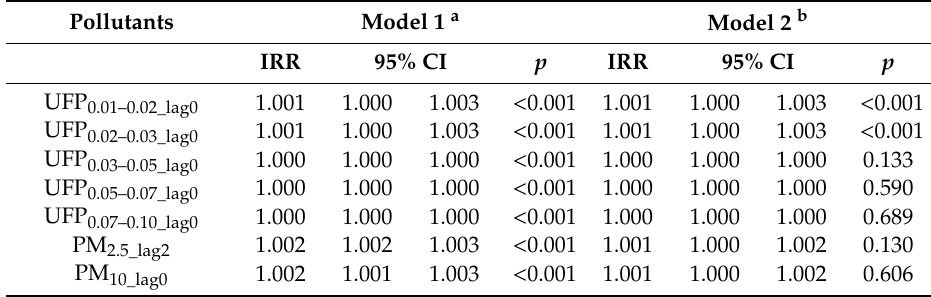
Table 2. Association between the daily number of consultations due to diabetes mellitus by all age groups and the average 24-h number concentration of UFP (number / cm 3 ); average 24-h concentration of PM 10 and PM 2.5 ( µ g / m 3 ) in the MOL, Slovenia between 1 January 2013 and 31 December 2017. Pollutants Model 1 a Model 2 b IRR 95% CI p IRR 95%